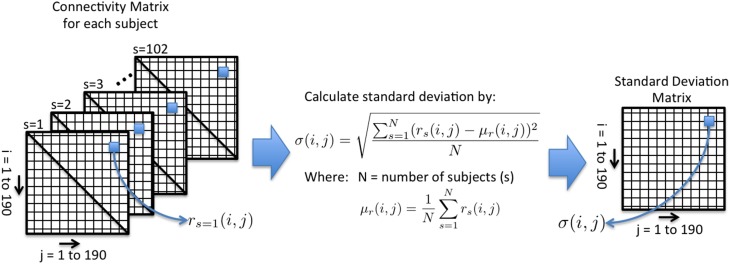
An illustrative schematic of Test 2. For each node pair, the standard deviation of the correlation (rs) is calculated across subjects(s). The Standard Deviation Matrix (SDM) is used to assess the reproducibility of a preprocessing strategy.